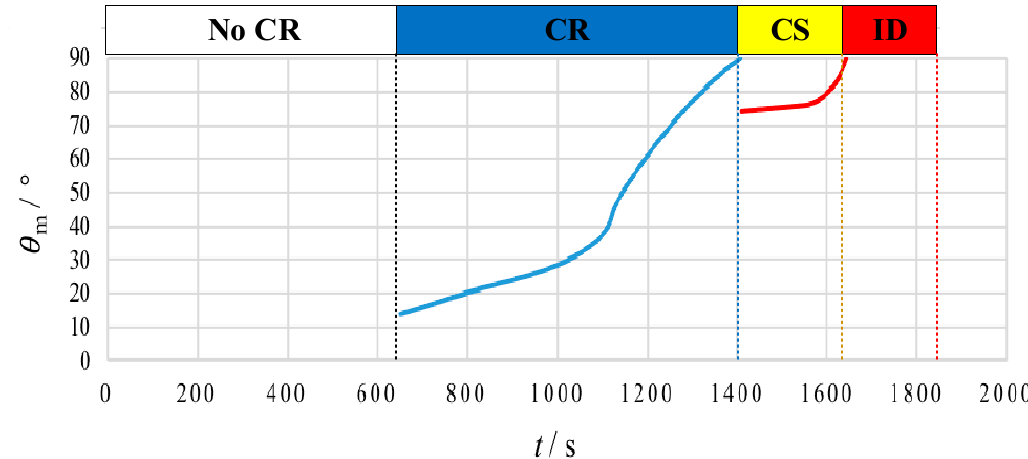
Figure 10. Minimum course-alteration angle for the stand-on vessel in a crossing situation. The blue and red curves represent the minimum course-altering amplitude required to ensure that ship domain and collision domain are not invaded at different moments by the stand-on vessel in the risk of collision and close-quarter situation stages.